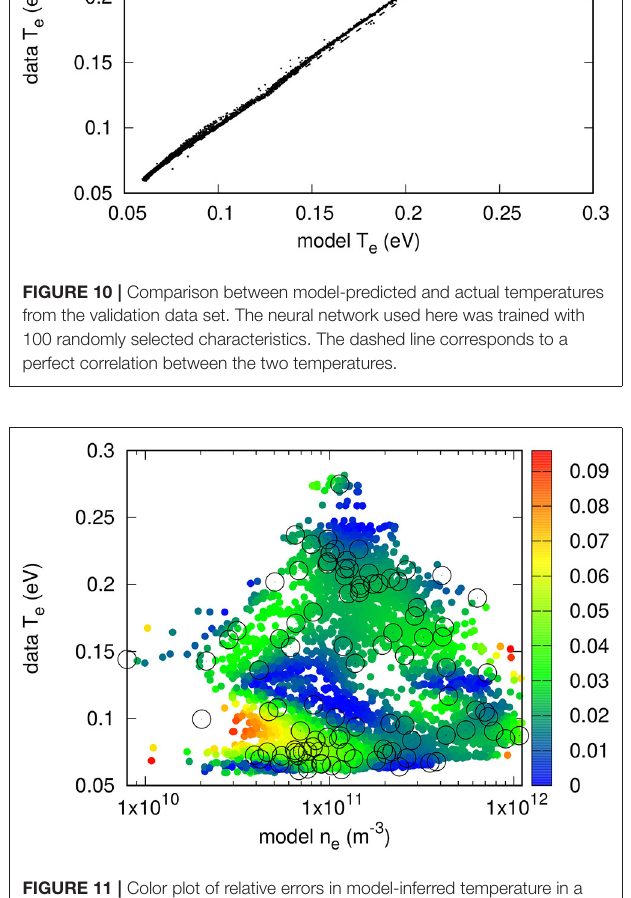
FIGURE 11 | Color plot of relative errors in model-inferred temperature in a validation data set consisting of approximately 5,000 randomly selected points. Circles show the positions of the 100 density and temperature pairs corresponding to the randomly selected